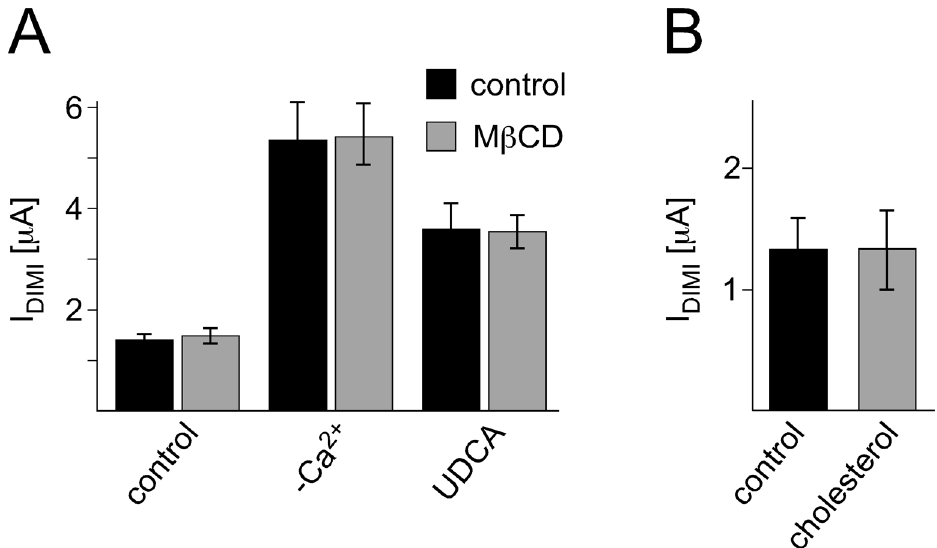
Figure 6. Cholesterol does not affect rBASIC activity. A) Removal of cholesterol does not influence rBASIC activity. Quantitative comparison of DIMI-sensitive rBASIC currents from oocytes that were incubated in low Na + OR-2 medium containing 20 mM M b CD (grey bars) or 20 mM mannitol (control, black bars) for approximately 2 h prior to recordings. Current amplitudes in the absence of any stimulus (control), in the absence of extracellular Ca 2 + ( 2 Ca 2 + ) and in the presence of 2 mM UDCA are shown. B) Addition of cholesterol does not influence rBASIC activity. Quantitative comparison of DIMI-sensitive rBASIC current amplitudes before (black bar) and after 10 sec application of 2 mM M b CD-balanced water-soluble cholesterol (grey bar). Error bars represent SEM, n =8.